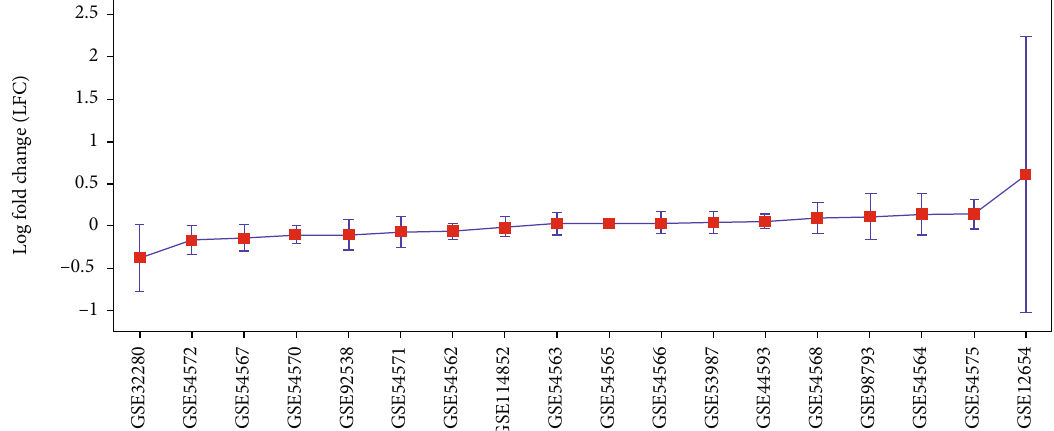
Figure 4: Error bar plot of the within-study variance of the PPARD expression among 18 major dispersive disorder RNA expression